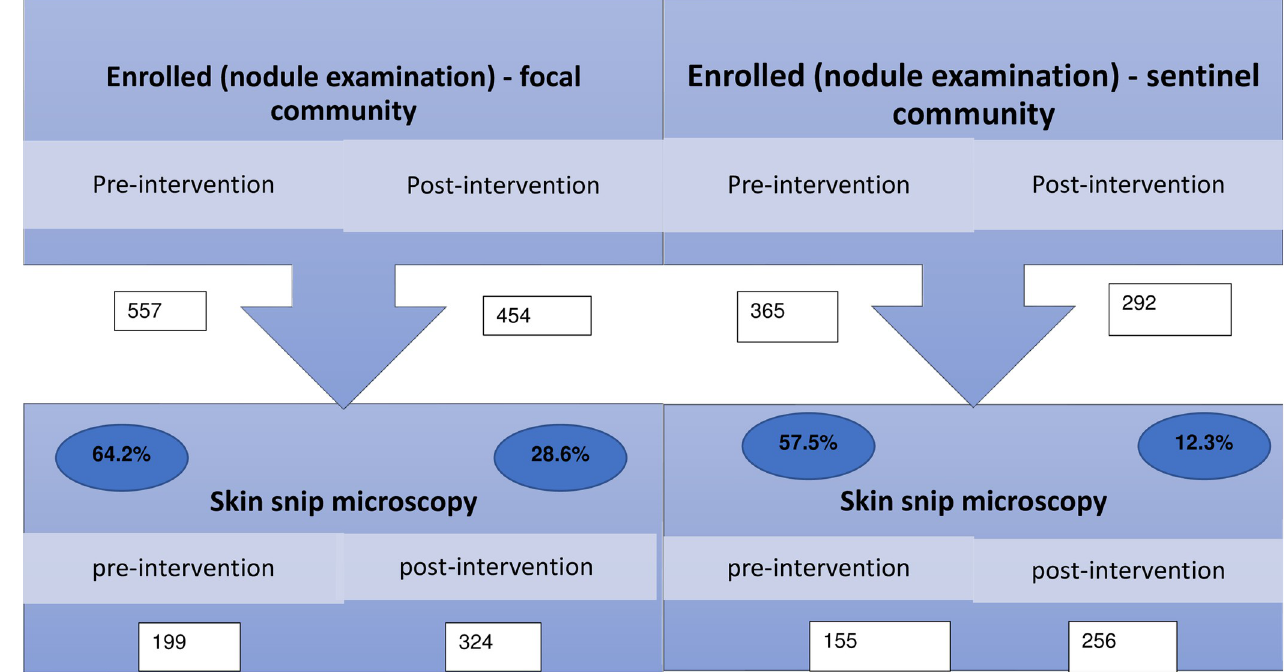
Fig 3. Chart showing population enrolled and screened before and after intervention. https://doi.org/10.1371/journal.pntd.0010591.g003 to 14.6% with IVM in 2011–2015. Similarly, in Massangam, there was a reduction of mf preva- lence by 23.2% following the two years of AIS compared to 20.3% reduction over 15 years of treatment with IVM (1996–2011) [15]. Similar results in accelerating elimination using doxy- cycline treatment as an “end-game strategy” were reported in Brazil and Venezuela [24].